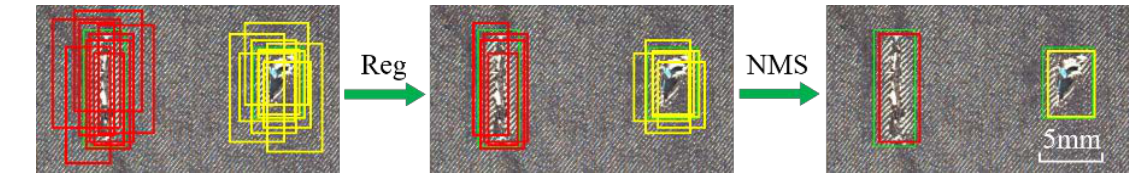
Figure 8. From positive anchors to proposals and finally to bounding boxes.